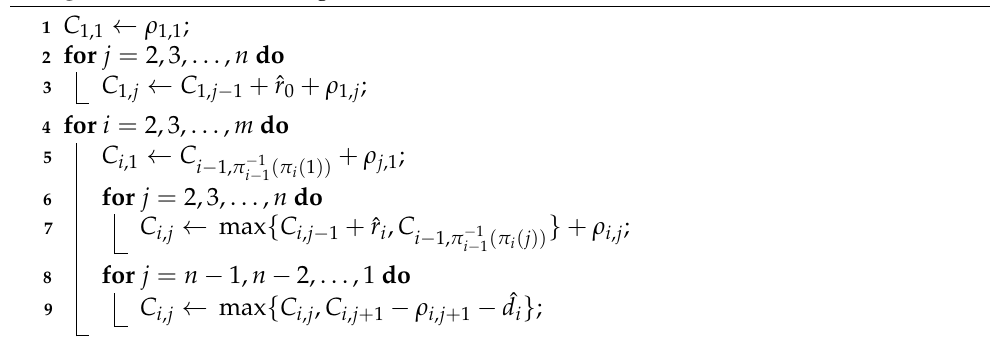
Algorithm 1: Constructing left-shifted